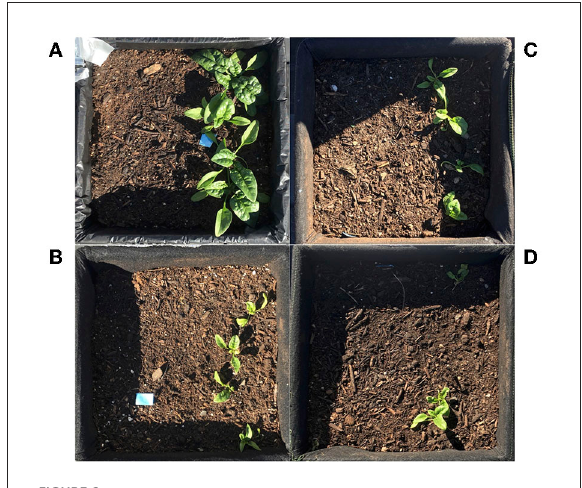
FIGURE6 Representative picture of spinach growth next to high and low wind speed exhaust vents and exhaust and control air treatments. (A) Spinach grown next to an exhaust vent and (B) next to a control fan both at low wind speed. (C) Spinach grown next to an exhaust vent and (D) next to a control fan both at high wind speed. The images for each group were ranked by size and the median image is shown